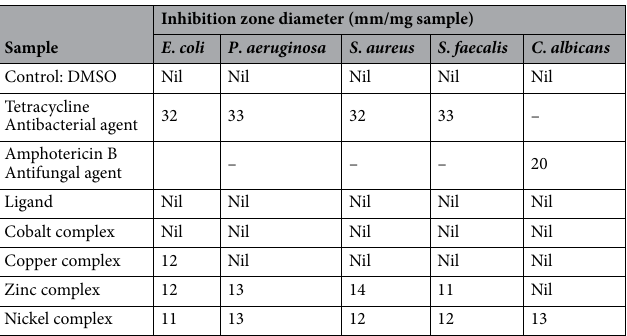
Table 2. Antimicrobial activity of the ligand and its metal(II) complexes. Nil, zero inhibition.